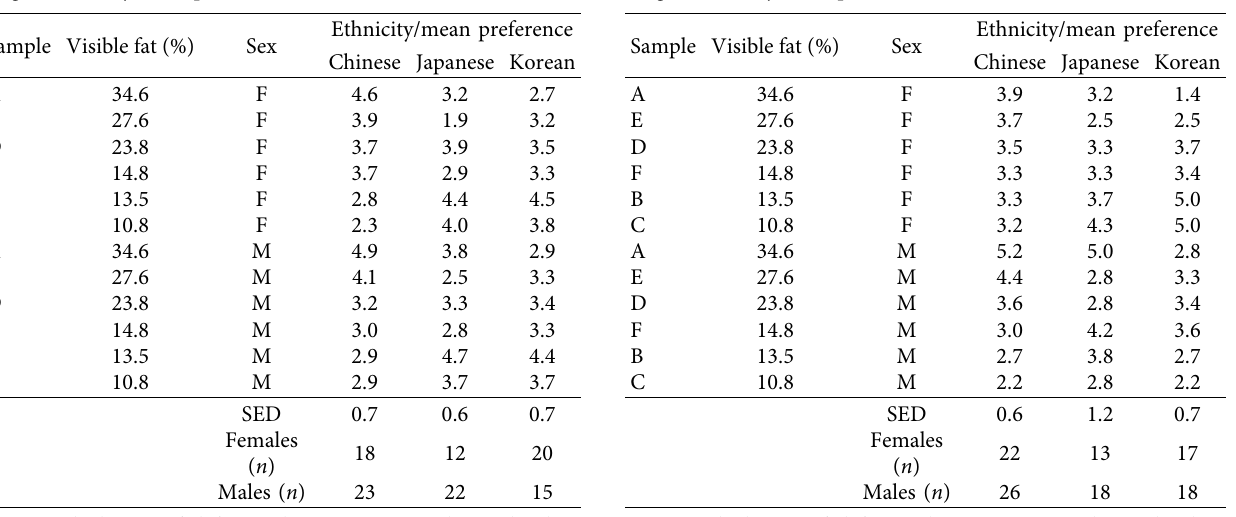
SED � standard error of difference between means within each ethnic